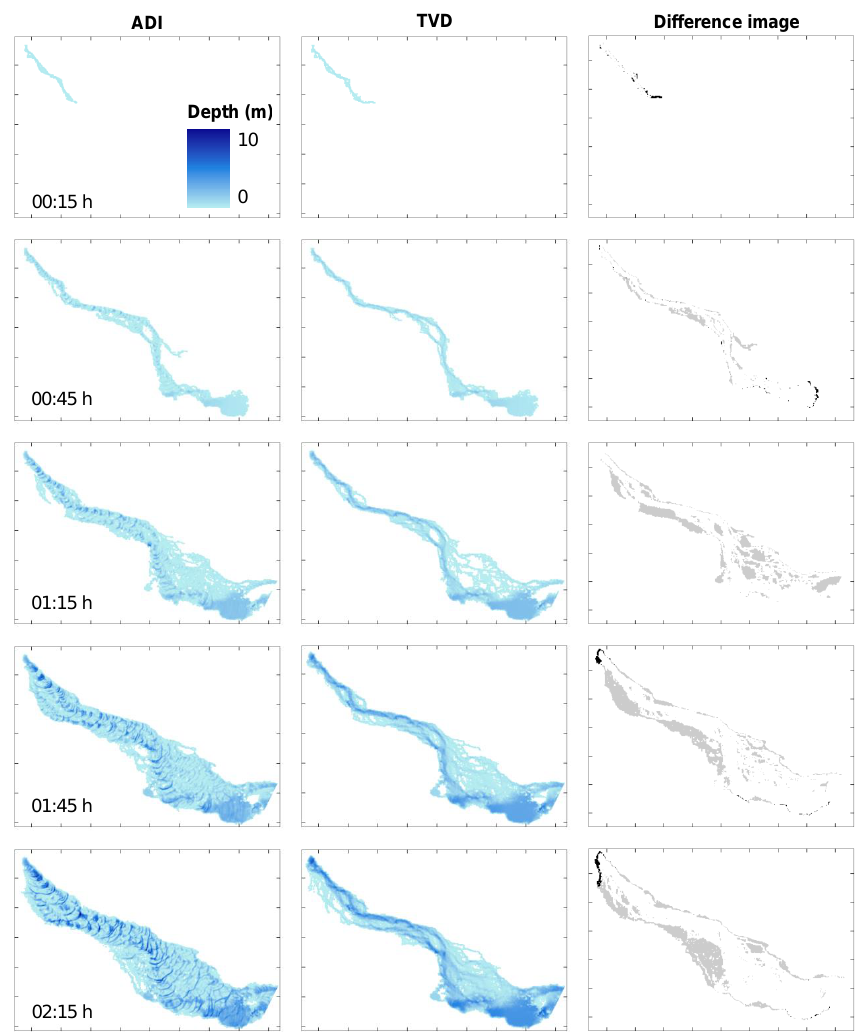
Figure 6. Comparison of GLOF inundation in the upper reaches of the Langmoche Khola using the ISIS 2-D alternating implicit direction (ADI) and total variation diminishing (TVD) solvers at selected time steps. Also shown is a difference image of inundation, where black and grey shading corresponds to areas inundated exclusively by the TVD and ADI solvers, respectively. See Fig. 1a for location. Inset tick marks spaced at 200m